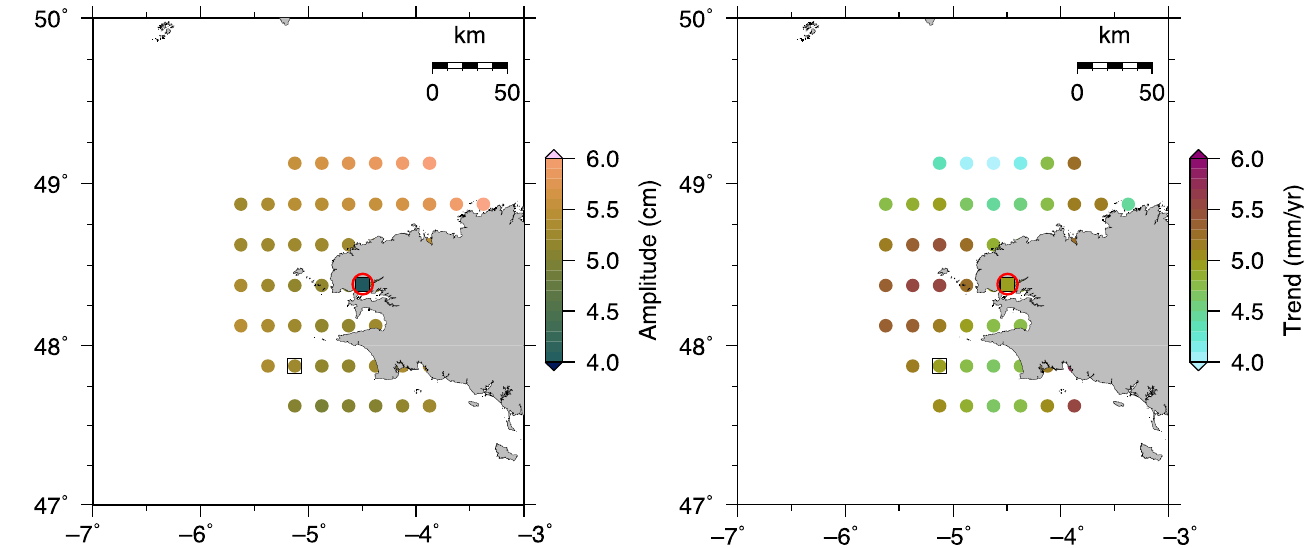
Figure 6. Annual amplitudes ( left panel ) and linear trends ( right panel ) estimated from the satellite altimeter data within 100 km from BRST. The filled square represents the GNSS station, and the open black circle is the tide gauge. The colored dot with a black square is the grid point from which the de-seasoned and de-trended satellite altimeter data has the highest correlation coefficient with those from the coastal GNSS. Table 2. Annual amplitudes and phases, and linear trends estimated from coastal GNSS and satel- lite altimeter SSH time series, Uncertainties indicate a 1-sigma standard deviation.